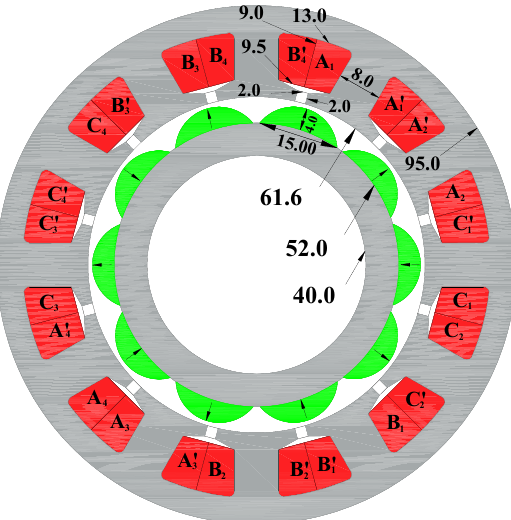
Figure 2. Geometry of the surface-mounted permanent magnet machines SPM model (mm).